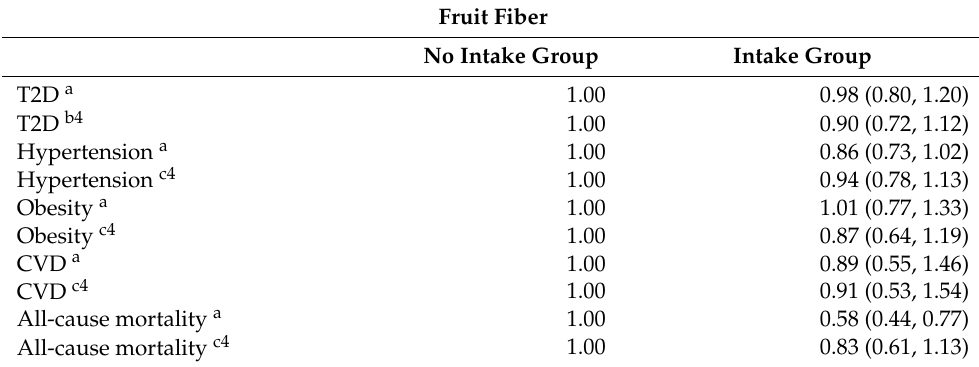
Table 6. Multivariable adjusted HRs (95%CI) of T2D, hypertension, obesity, CVD, and all-cause mortality according to the classification of intake of fruit fiber or